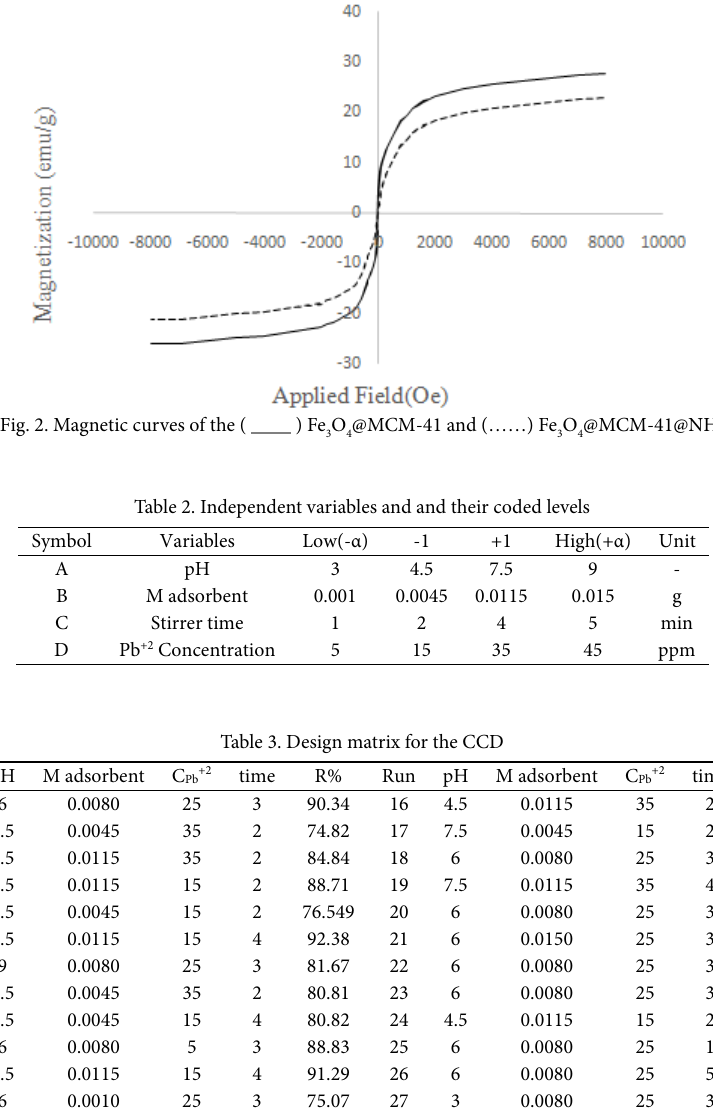
Fig. 1 FT-IR spectra of synthesis nanomagnetic.